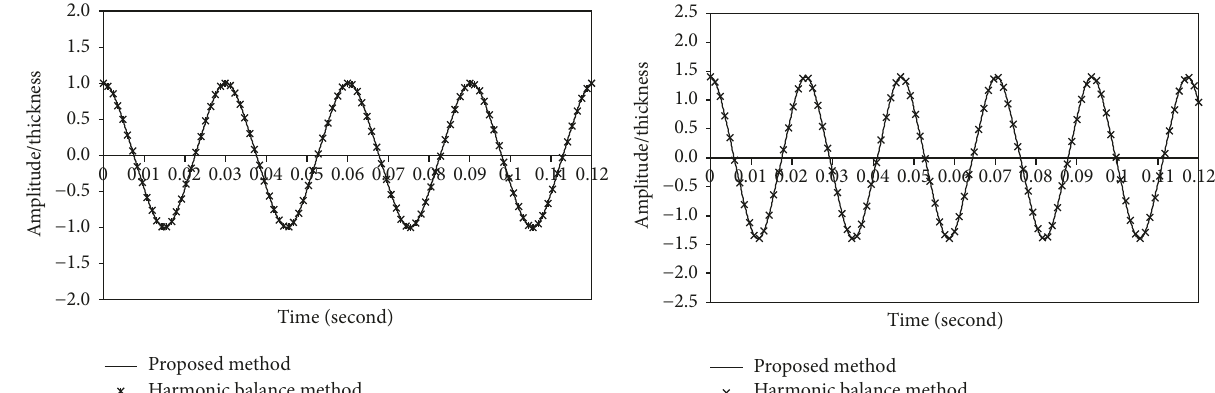
methodResonant freqeuncy ratio, 휔 n /휔 o Proposed method Harmonic balance